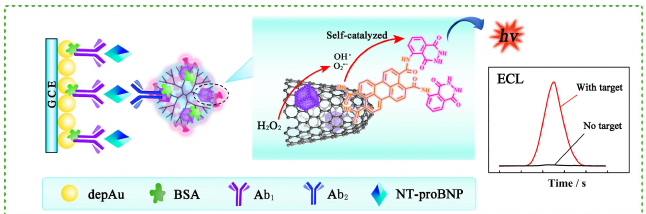
Figure 1. Schematic of a sandwich-type BNP immunoassay used with an ECL immunosensor [60]. Glassy carbon electrodes, modified with Au nanoflowers, are functionalized with primary antibodies. Secondary antibodies are conjugated to single wall carbon nanohorns linked to bimettalic nanocubes and loaded with a novel self-catalyzed luminescence emitter.